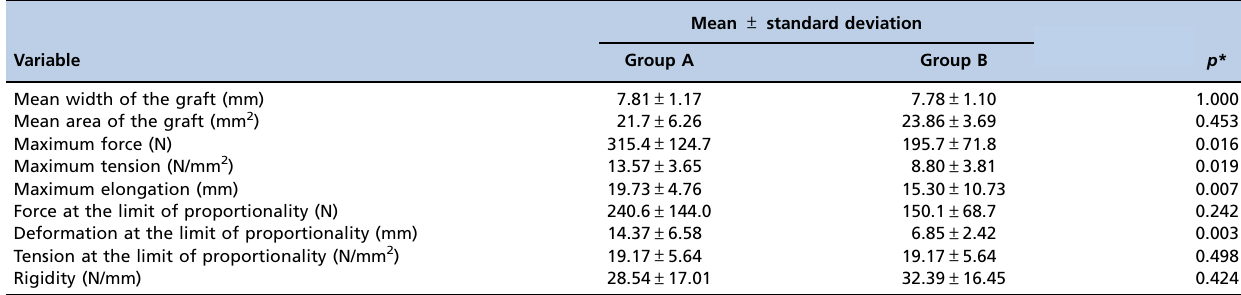
Figure 4 - Photo of an anatomical piece of the tibia from group A (fixation without the screw), showing the mechanical trial with the Kratos apparatus in which the tibia was maintained on an immobile support. Arrow: Preservation of the tibial insertion of the hamstring tendons. Table 1 - Comparison of the means according to the Mann-Whitney